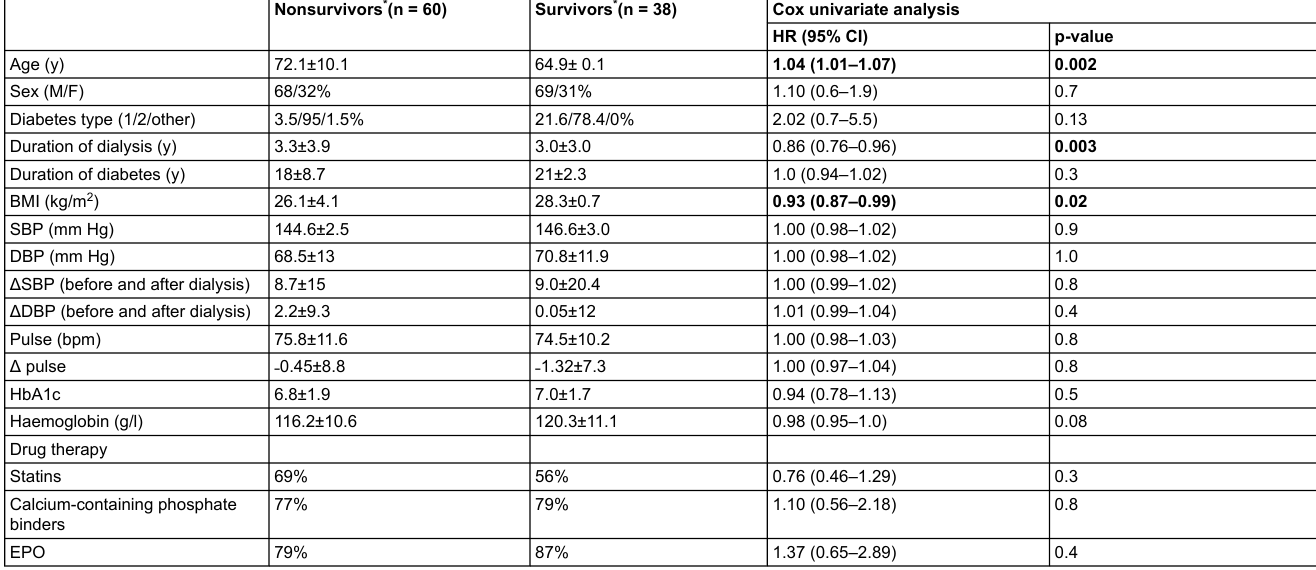
Table 4: Clinical characteristics of 5-year survivors vs nonsurvivors (total n = 98) and comparison by univariate Cox regression